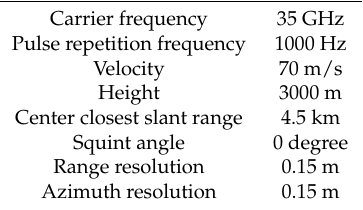
Table 10. Ka-Band SAR system parameters.